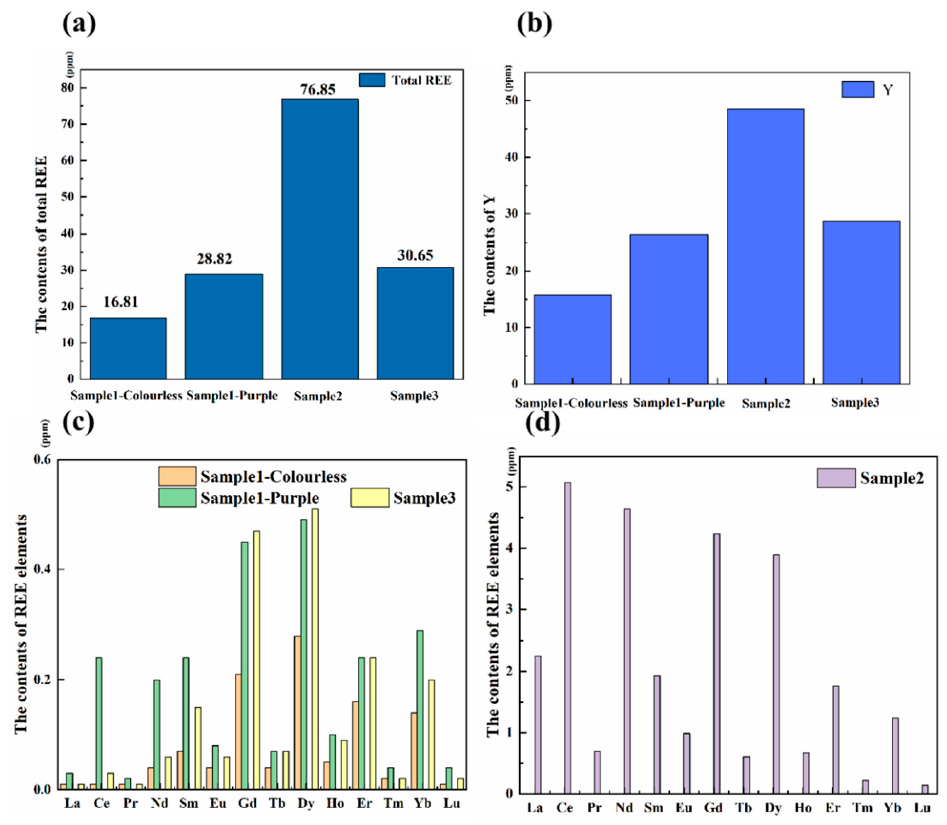
Figure 2. ( a ) The total content of REE in the samples. ( b ) The content of Y in the samples. ( c ) The content of each rare-earth element (except Y) in the sample 1 (colorless and purple parts) and sample 3. ( d ) The content of each rare-earth element (except Y) in the sample 2.